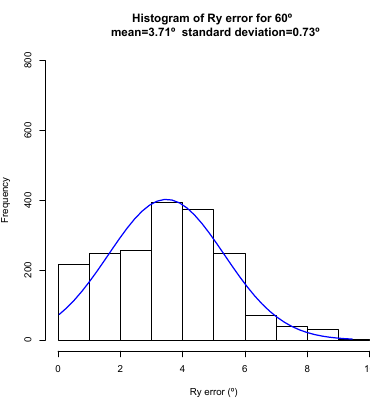
Figure 28. Histogram of R x for 60 ◦ of rotation. The curve in blue is the curve estimated by R as the Gaussian curve that is closest to the obtained data.